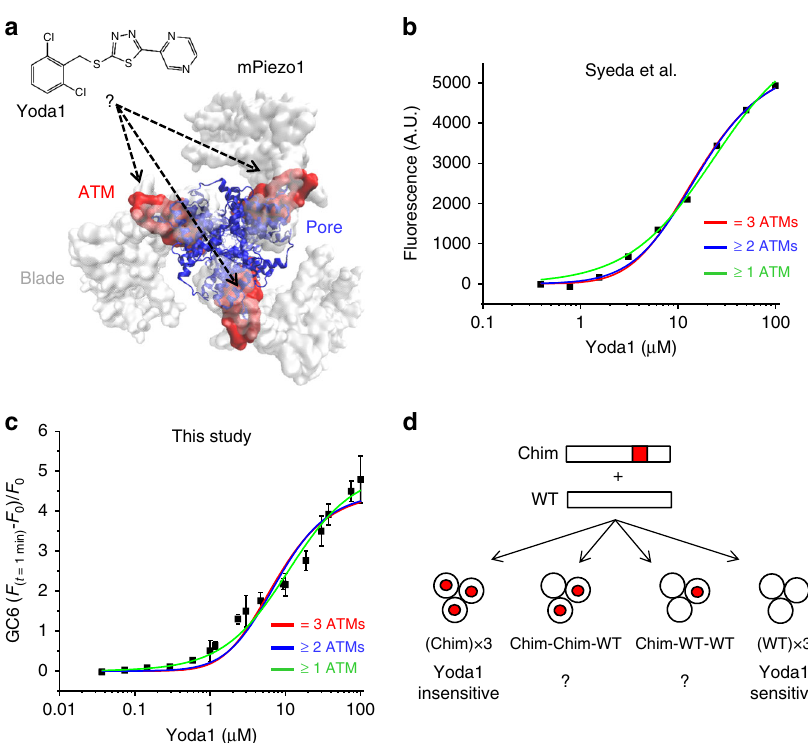
Fig. 3 Experimental strategy to determine the gating mechanism of Piezo1. a mPiezo1 cryo-EM structure (PDBID:6B3R, image created using VMD) viewed from the intracellular side and depicting the blade (white surface), the pore (blue cartoons) and the ATM (red surface) in each subunit. The interaction between the ATM and Yoda1 (represented using ChemDraw) is unknown. Chemical gating of Piezo1 may require the activation of at least one, at least two, or all three ATM. b , c Curve fi tting of Yoda1 dose – responses obtained from Syeda et al. ( b ) or from us ( c ) using models describing the interaction of the agonist with one or more (green), two or more (blue) or three (red) ATM. These models correspond to fi ts with Eqs. 2, 3, and 4, respectively. All three models were able to fi t well the data (Supplementary Table 2). d A minimum ATM stoichiometry for chemical gating of Piezo1 could be determined by characterizing channels harboring Yoda1-sensitive (WT) and Yoda1-insensitive (Chim) subunits. In panels c, the experiment was done in duplicate and repeated fi ve times. error bars =